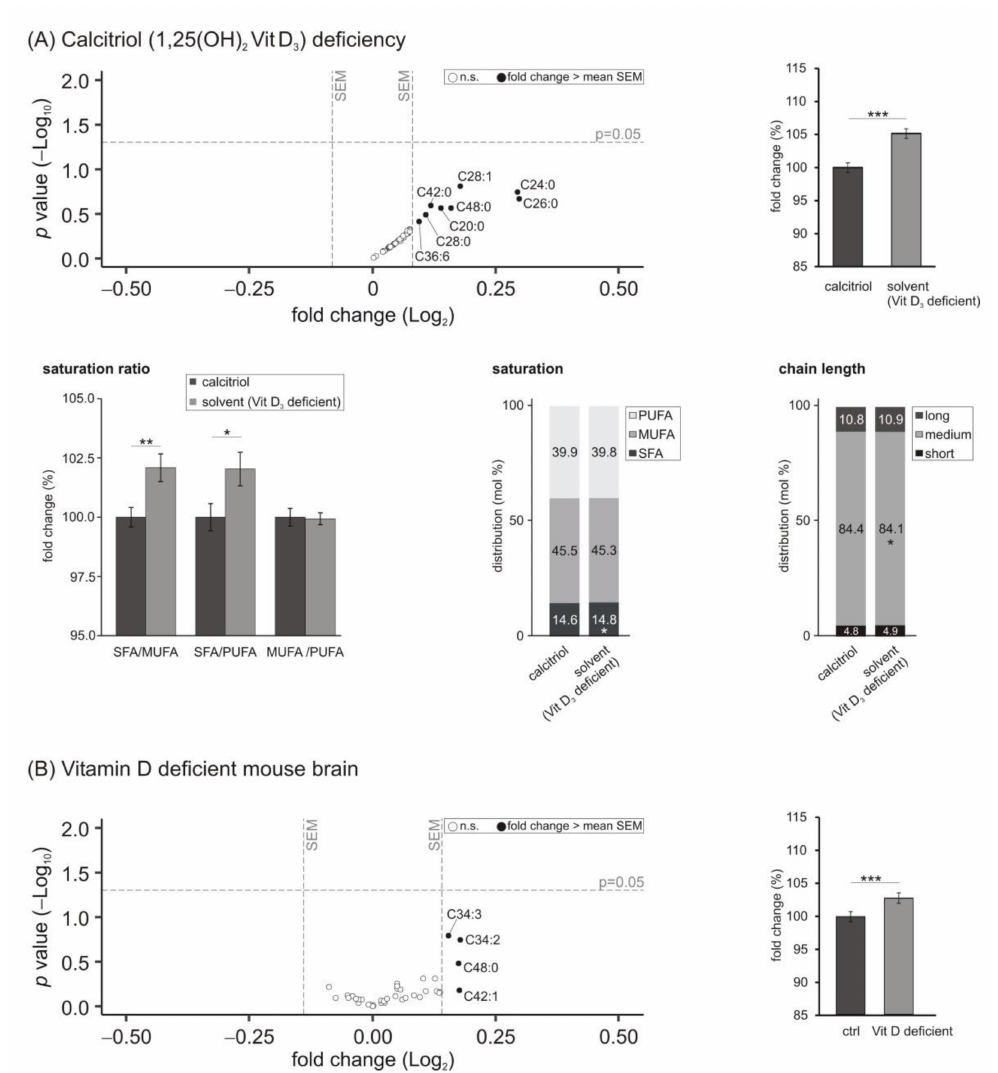
Figure 1. Effect of vitamin D 3 deficiency on phosphatidylcholine (PCaa) species. ( A ) The levels of PCaa in SH-SY5Y wt cells incubated with the solvent control (ethanol) were compared to cells treated with 1,25-dihydroxy vitamin D 3 . In the volcano plot, the fold change ( x -axis) of each of the 43 analyzed PCaa species (dots) was plotted against the corresponding p -value ( y -axis). The two vertical lines represent the mean SEM. The horizontal line marks the p value of 0.05, which was set as statistical significance. Filled black dots symbolize PCaa species with a fold change greater than the mean SEM without reaching significance and empty dots represent species with a fold change within the mean SEM. The bar chart on the right shows the relative fold change of all measured PCaa species comparing calcitriol-treated with solvent-control-treated SH-SY5Y cells. Below the volcano plot, ratios indicating the saturation state of the fatty acids within the PCaa species and the distribution of saturation and chain length in mol% are shown. ( B ) Analyzed PCaa species in brain samples of vitamin D deficient mice compared to control-fed mice in a volcano plot and relative fold changes of all measured PCaa species in a bar chart. Error bars represent the standard error of the mean (SEM). Statistical significance was set as * p ≤ 0.05, ** p ≤ 0.01 and *** p ≤ 0.001; n.s. not